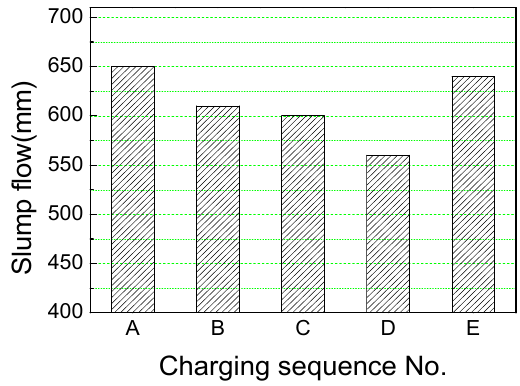
Figure 1. E ff ect of charging sequence on the slump-flow of self-compacting concrete Figure 1. Effect of charging sequence on the slump-flow of self-compacting concrete (SCC).